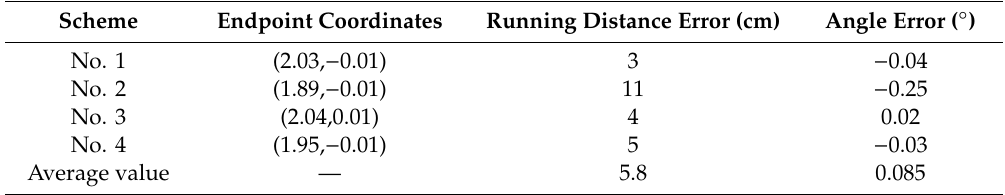
Table 2. Error statistics from the straight line running positioning